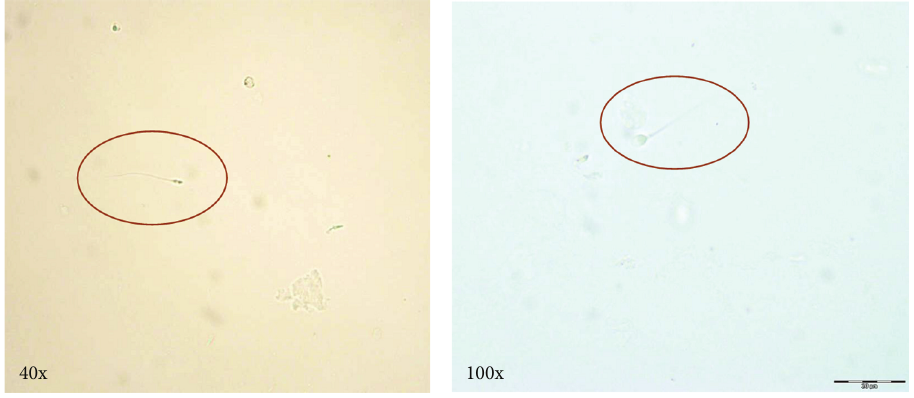
Figure 1: Postejaculatory urine